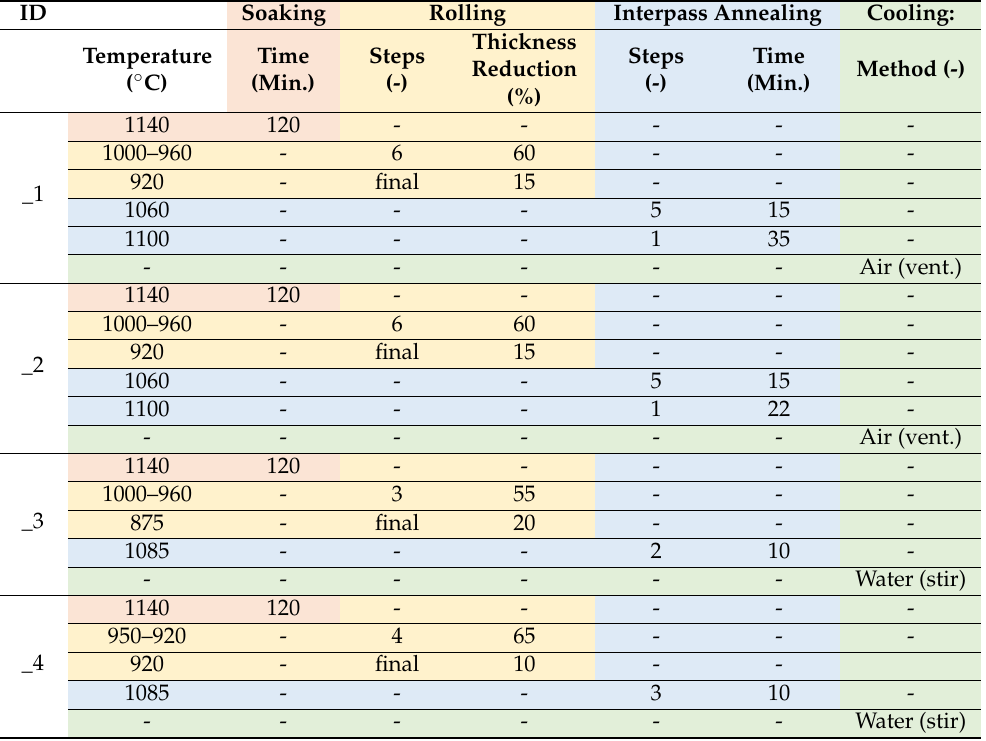
Table 2. Parameters applied in processing of the trial steels (colors relate temperature to other information of individual processing step, i.e. red: soaking, sand: rolling, blue: interpass annealing, green: